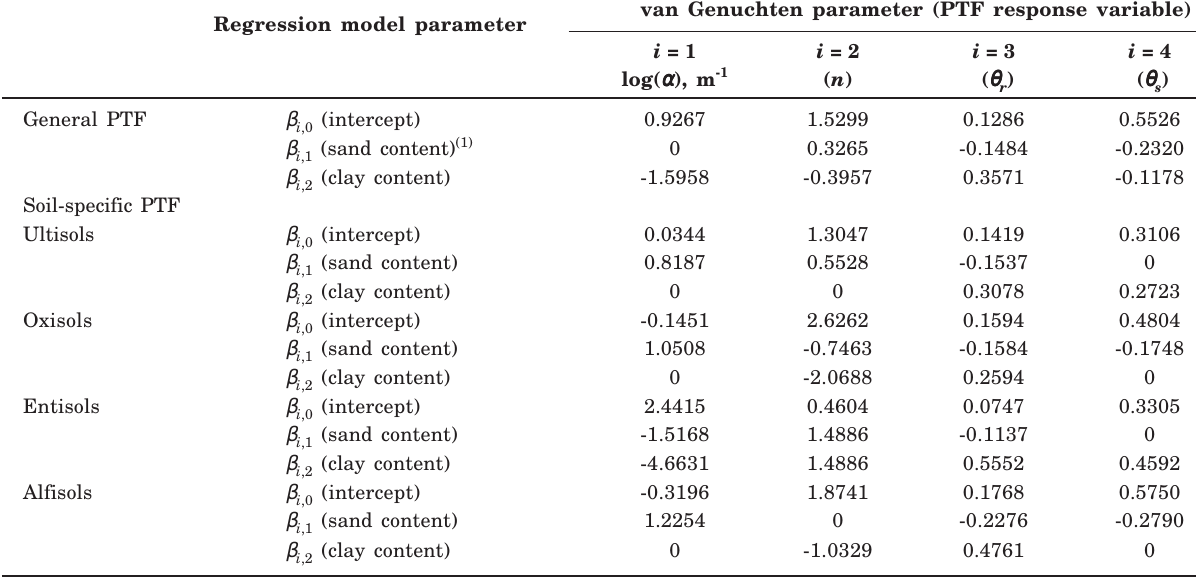
Table 5. Estimates of linear multiple regression parameters for general PTF- 2v as well as for soil-class- specific PTF- 2v , obtained from the development-subset ( N =